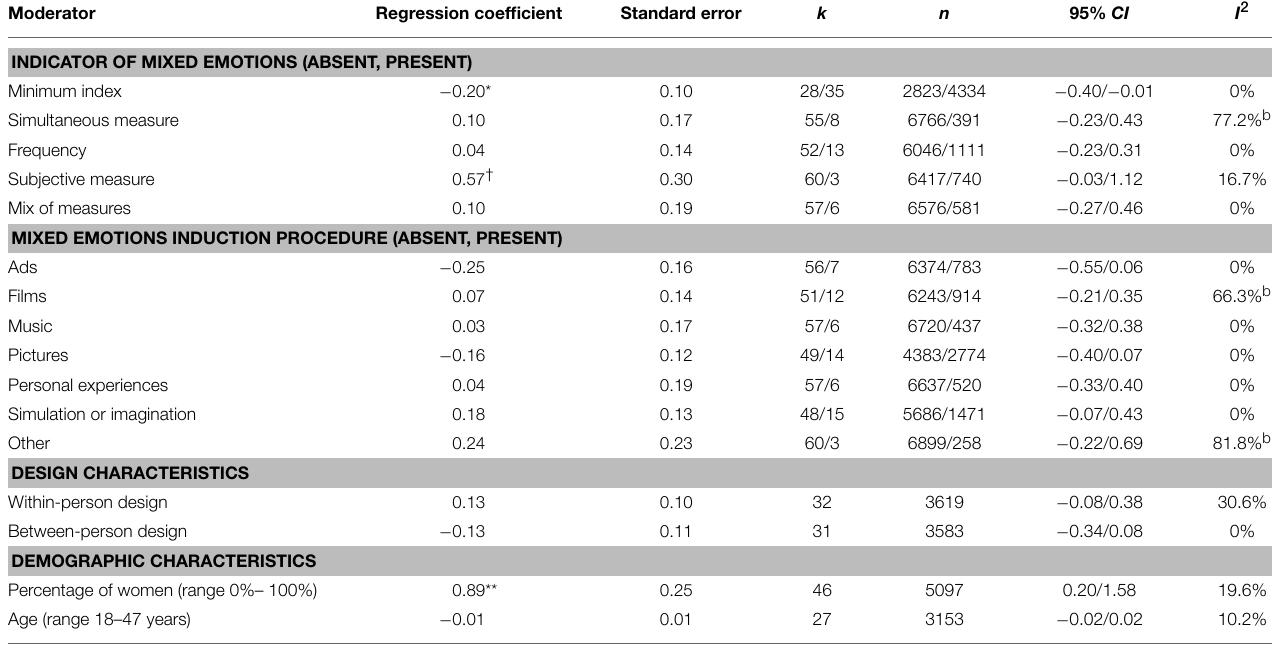
Columnskandnrepresentnumberofstudiesandnumberofparticipants,respectively.Whereapplicable,thesearereportedseparatelyforeachlevelofthemoderatorvariable(indicated in parentheses at the end of each moderator name). Where a variable is coded as “absent, present,” absent was coded as 0 and present was coded as 1; thus, a positive regression coefficient indicates that studies in which the variable was present had larger effect sizes, and a negative regression coefficient indicates that studies where that variable was present